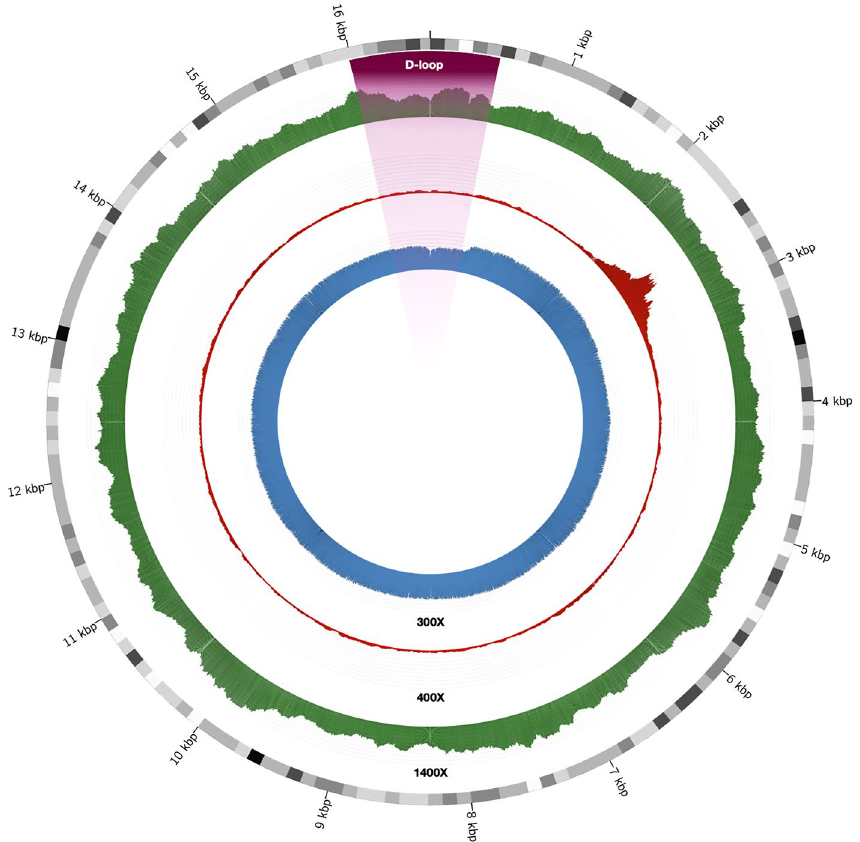
Figure 1. Circular plot of the depth of coverage for short-read and long-read sequencing in the mtDNA of an exemplar sample. Short-read WGS and WES data are colored in green and red, respectively. Long-read WGS data is shown in